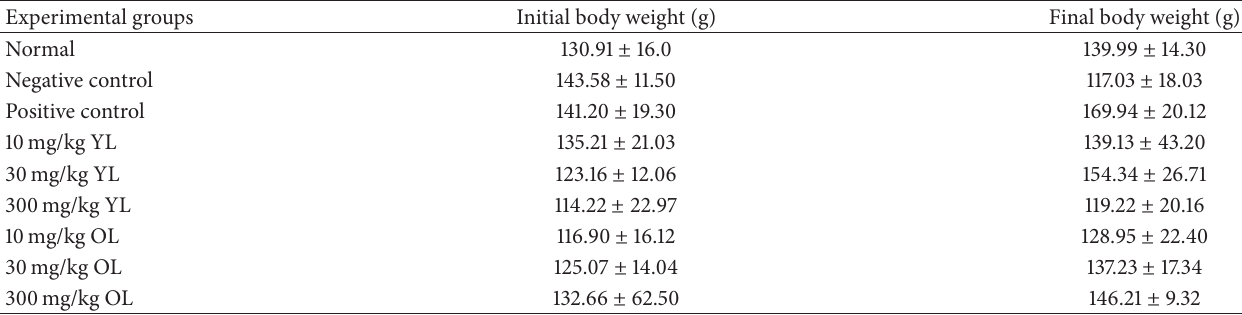
Table 3: Effect of old and young ethanolic leaf extract of V. amygdalina on body weight of experimental rats. Experimental